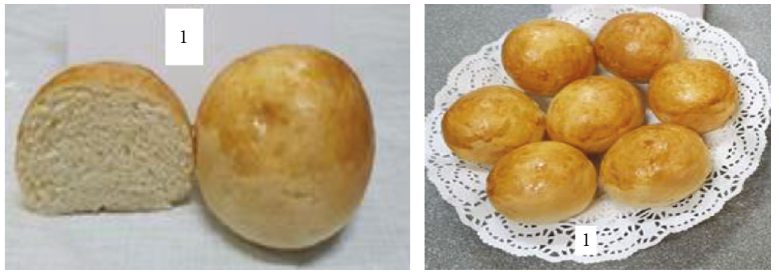
Figure 2: Sample no. 1: control sample with sugar.